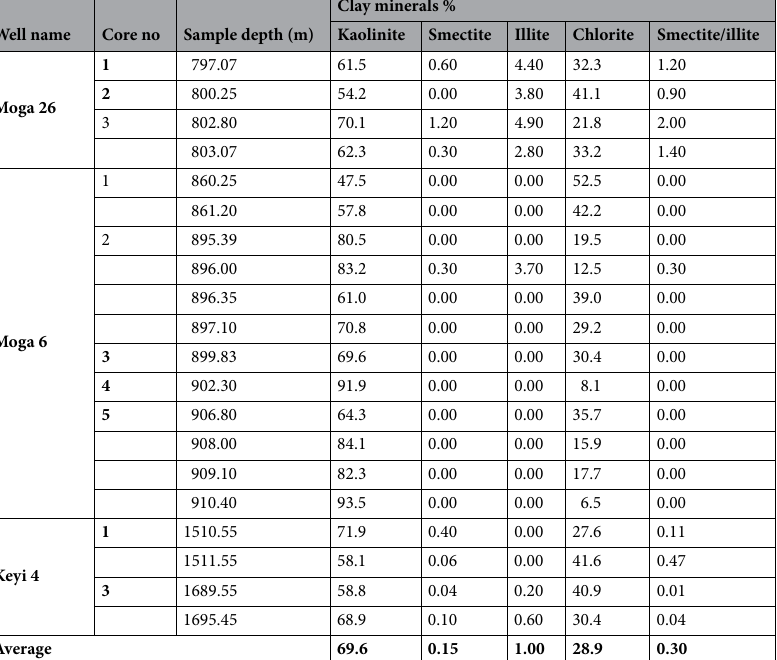
Table 6. Result of the clay minerals analysis for the analysed samples from the studied cores intervals based on XRD